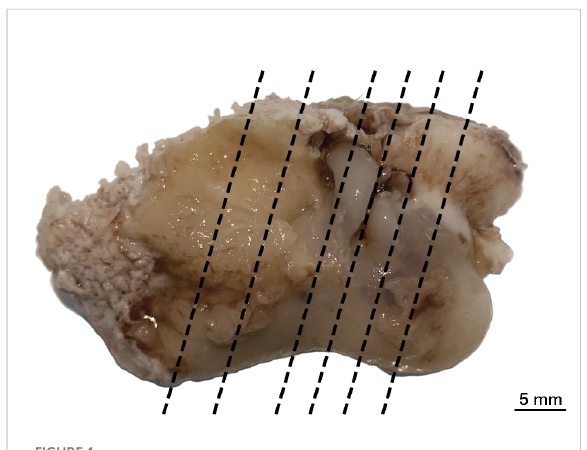
FIGURE 1 Sectioning planes of the left tympano-periotic complex. The background was manually removed from the